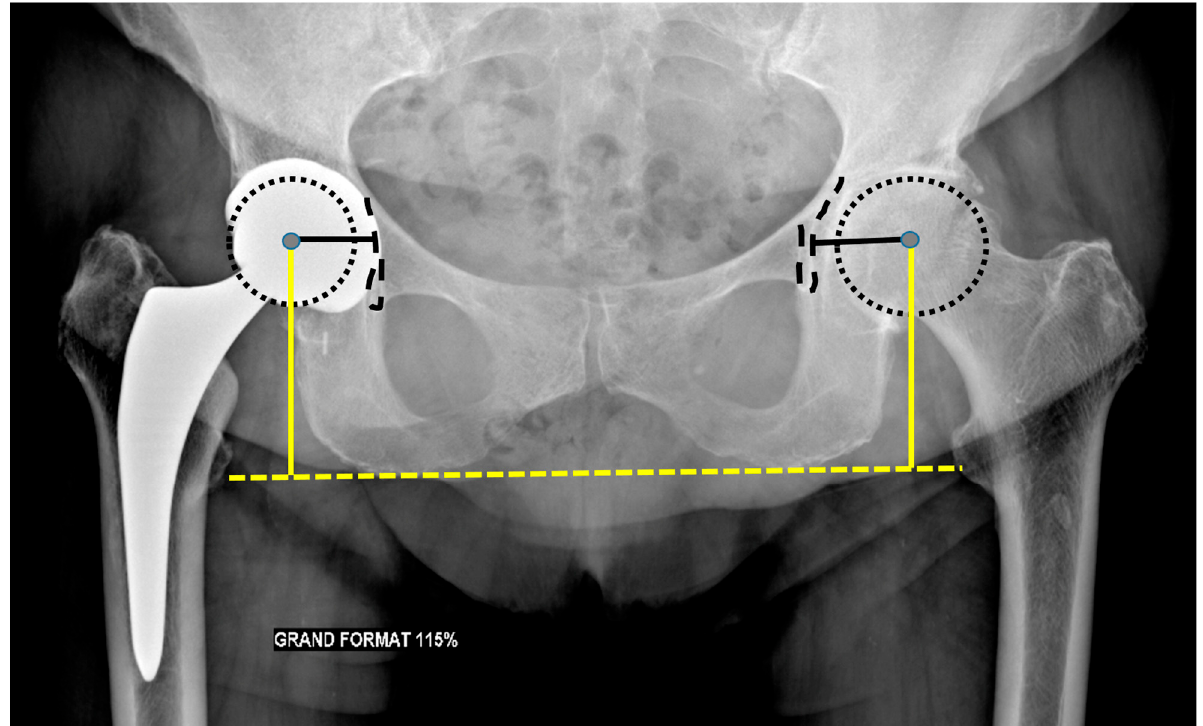
Figure 6. Acetabular centers of rotation. Pelvic anteroposterior radiograph. The horizontal center (black line) corresponds to the distance between the femoral head (dotted circle) center (grey point) and the teardrop (large black dotted curve) shadow, the vertical one (yellow line) to the distance between the center of the femoral head and the transischiatic line (dotted yellow line).